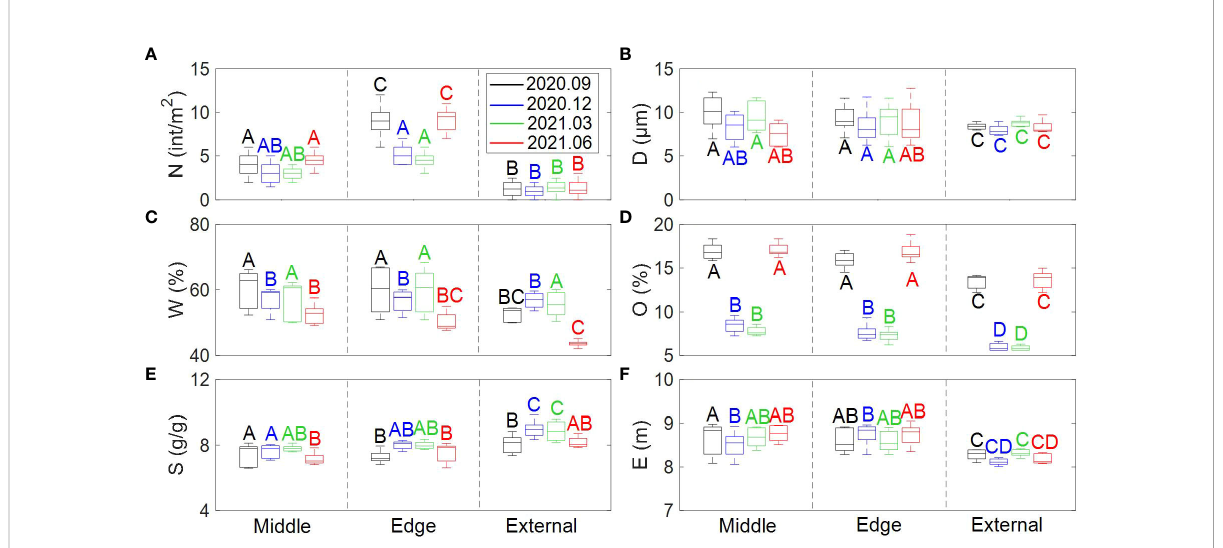
FIGURE 6 Box plots of crab burrow distribution and environmental variables among different plant zones and in different seasons. (A) The density of crab burrows; (B) The median grain size; (C) The water content; (D) The organic matter content; (E) The soil salinity; (F) The elevation. Data is shown as means ± SE (n=10). All ANOVA tests are signi fi cant (P<0.05 in each case). A box plot is a chart that shows data from a fi ve-number summary including minimum, Q1 (First Quartile), median, Q3 (third Quartile), and maximum (from top to bottom). Different letters denoted signi fi cant differences between